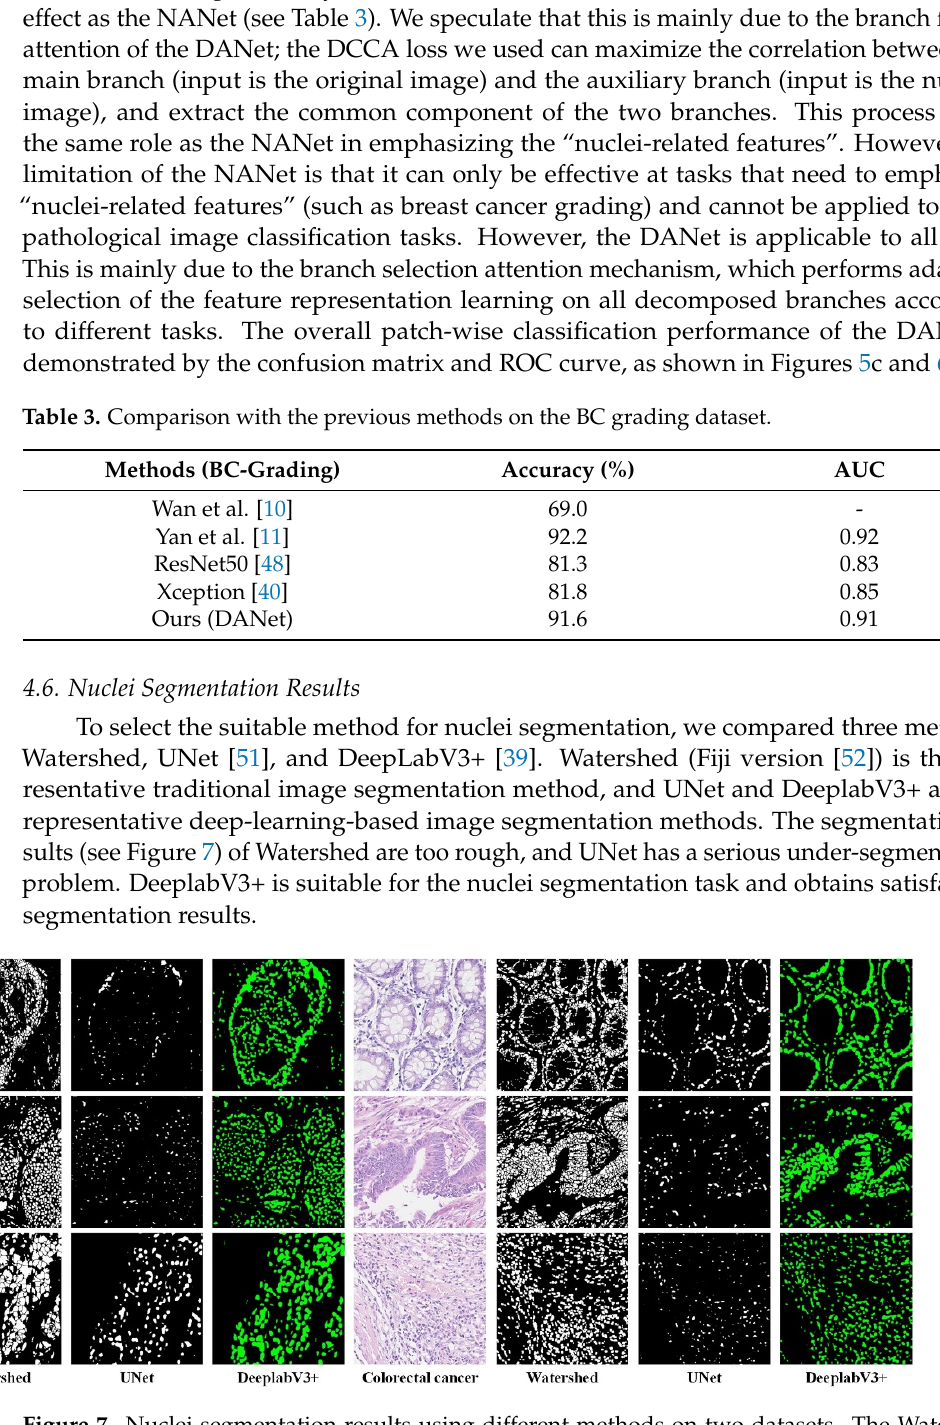
Table 3. Comparison with the previous methods on the BC grading dataset.